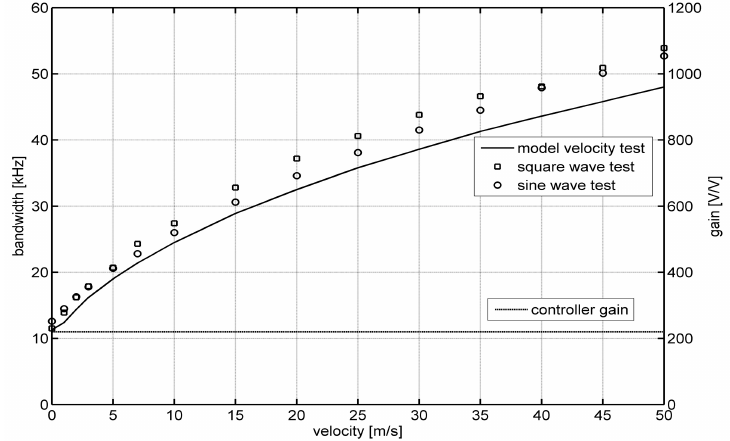
Figure 5. Dependence of the bandwidth of a constant-temperature anemometer on flow velocity when the constant-bandwidth function is off.